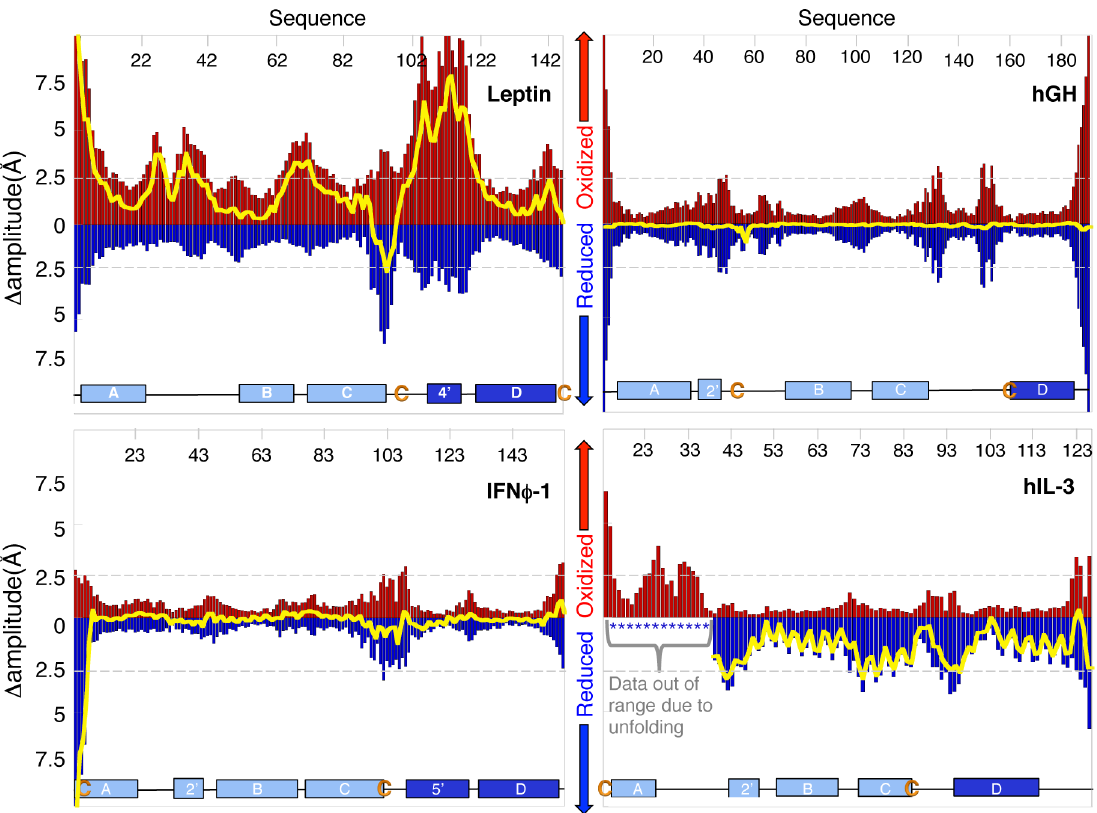
Figure 7. Native state dynamics of leptin, hGH, IFN -1 and hIL-3. Structure based all-atom simulations were performed to obtain NSD. Data for reduced and oxidized protein are shown in blue and red, respectively. The overall fluctuations are shown as bar graphs and the difference between the two states is plotted as a yellow line. The protein sequence is displayed at the top of the graphs and a cartoon of secondary structures is displayed at the bottom (indicating the position of the N- versus the C-terminal loop in light blue and dark blue respectively). Leptin shows an interesting shift in dynamics where the oxidized state is more dynamic than the reduced state over the majority of the structure. The disulphide bridge, not only closes the covalent loop, but also acts as a point of tension inducing dynamics, far from the disulphide bridge. Helix A in leptin shows increased dynamics in the oxidized state, opposite to what is observed in the other PLBs. The decreased dynamics in helix A for the other PLBs is a result of the disulphide bride pining down helix A, thus restricting its dynamics. Interestingly helix A in hIL-3 completely unfolds in the native basin in the reduced state (the data dwarfs the effects on the rest of the sequence and is not included in this figure for clarity). hGH is has an ‘‘empty’’ covalent loop (a ‘‘cinch’’ like structure) of about 100 residues. The plot for hGH shows no significant change of the overall dynamics between reduced and oxidized protein, except for the expected local effect around the disulphide bridge. This implies that that the formation of the covalent loop alone has no effect on the NSD while the presence of a threaded topology piercing the lasso changes the entire protein